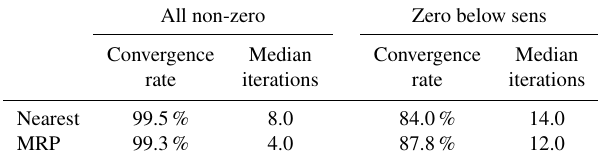
Table 6. The convergence rate and median number of iterations for retrievals made with the MRP and the nearest background profiles for the fog case on 7–8 March 2020. The “all non-zero” column refers to retrievals made with diagonal components of the Jacobian matrix made to be always non-zero, whilst the “zero below sens” column refers to retrievals made with the Jacobian matrix allowed to be zero where simulated radar reflectivity is below the